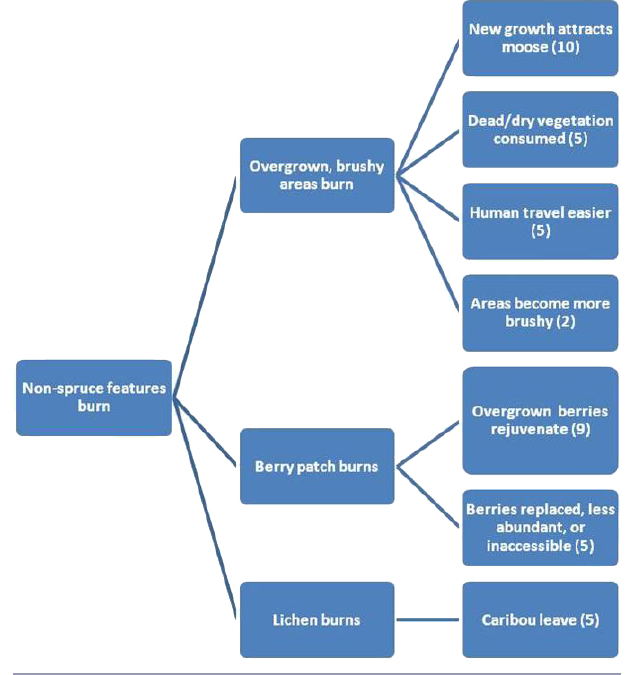
Fig. 7 . Fire effects as reported by Koyukon respondents. First column represents general type of burn, second column represents specific type of burn, and third column represents effects of burning. Note that the numbers in parentheses refer to the number of respondents who provided that response.